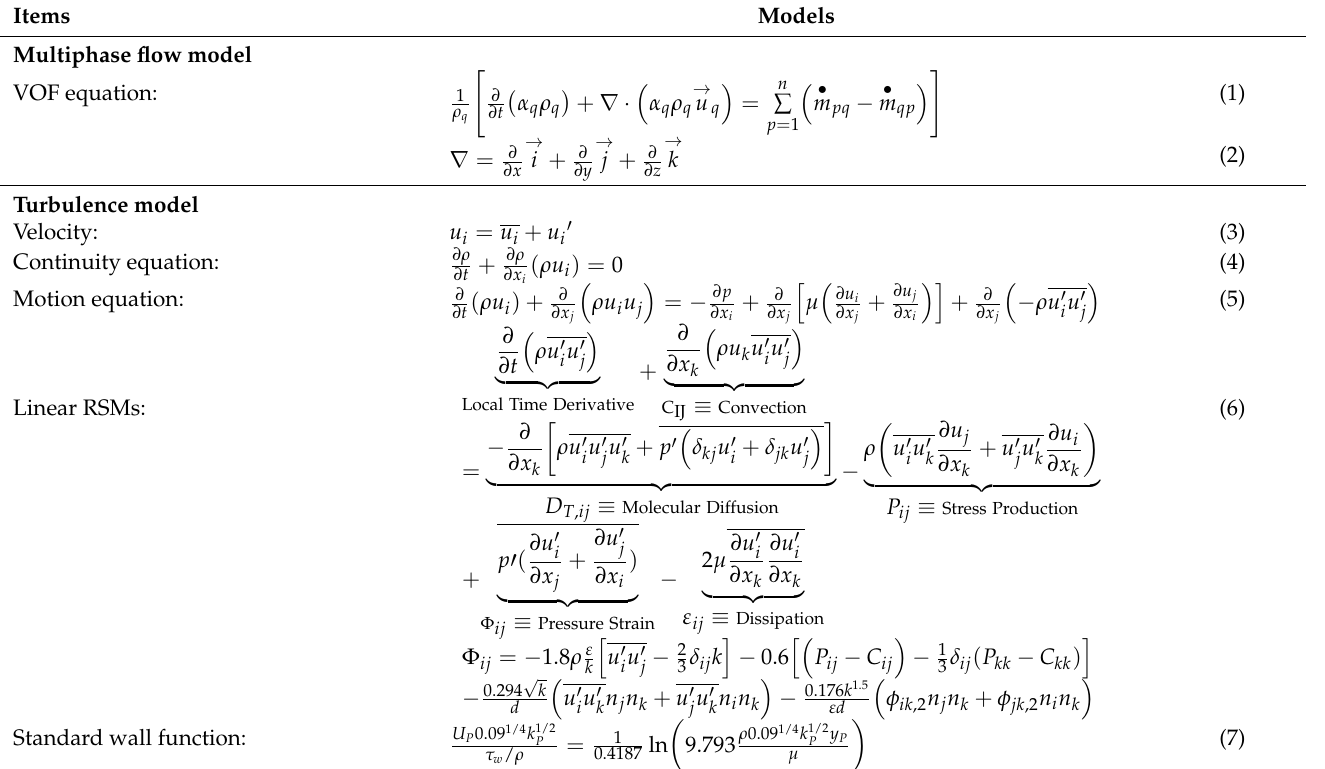
Table 2. Multiphase and turbulence models for CFD simulation.